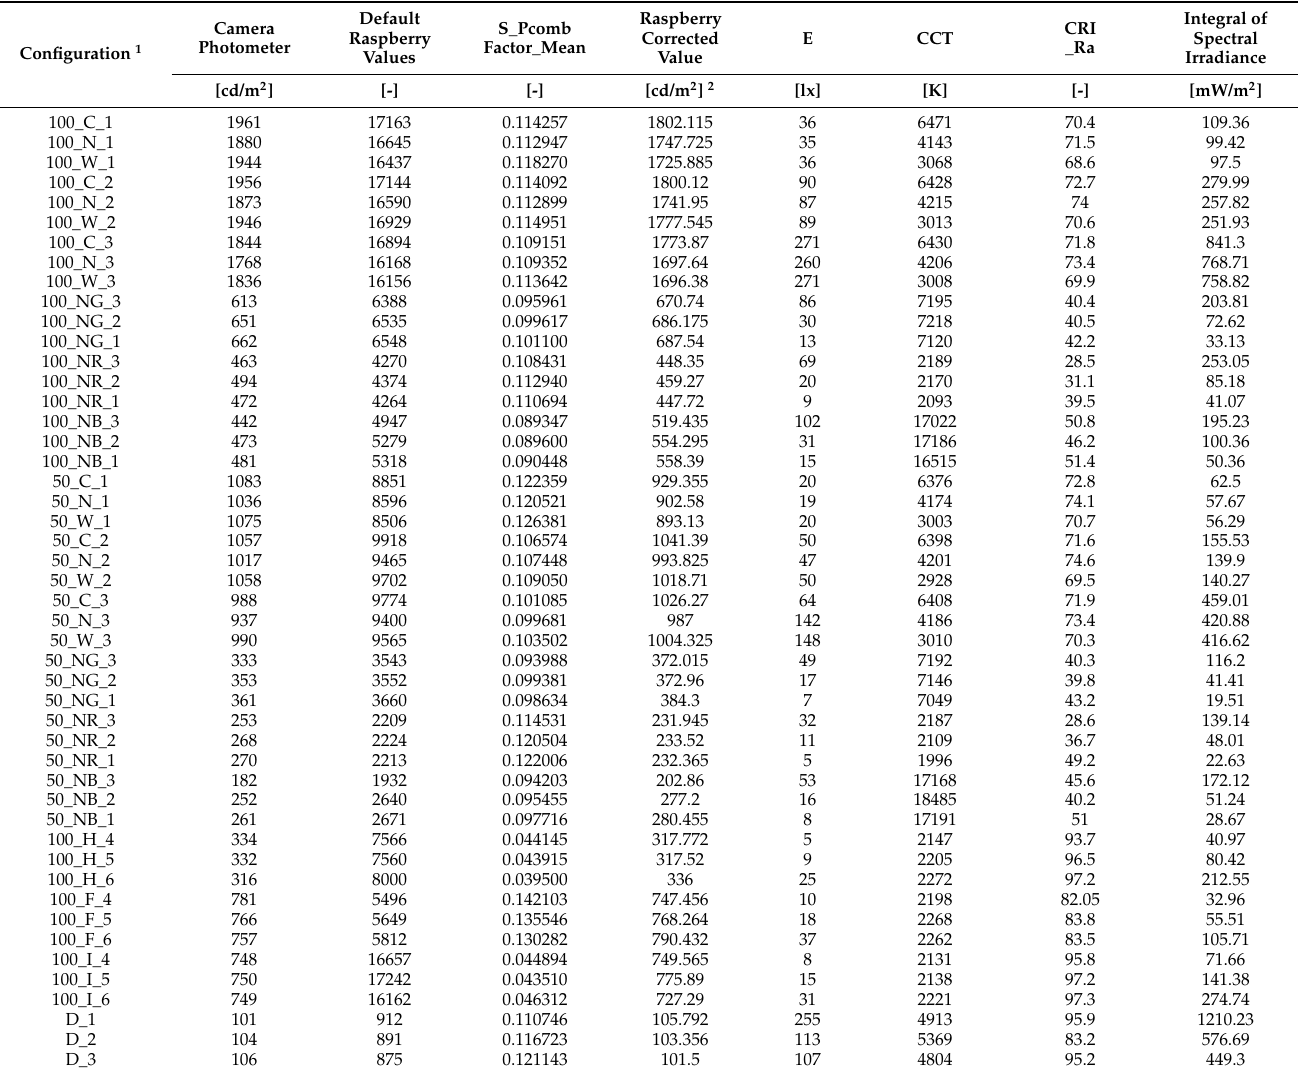
1 C = cool white, N = neutral white, W = warm white, NG = green filter, NR = red filter, NB = blue filter, H = halogen, F = fluorescent, I = incandescent, D = daylight. 2 values obtained by considering an average Scomb = 0.105 for all configurations with LED panel, 0.042 for configurations with halogen lamps, 0.116 for configurations with daylight, 0.136 for fluorescent and 0.045 for incandescent